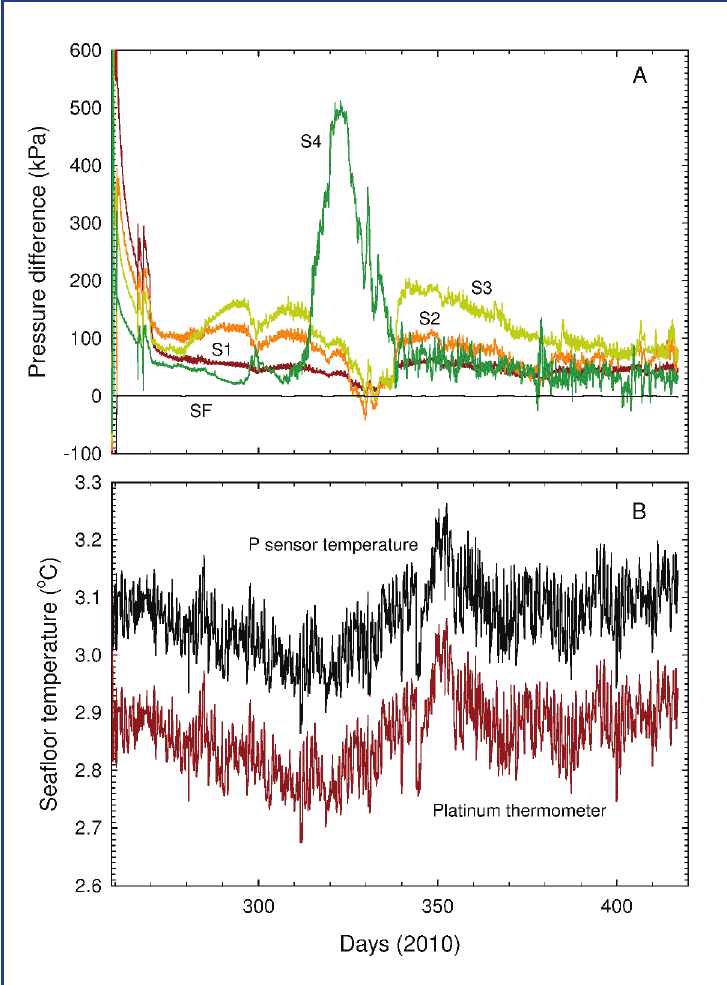
Figure 8. Full history of [A] seafloor (tides filtered) and relative formation pressures and [B] seafloor temperature observed prior to failure of the seafloor pressure sensor on 21 February 2011 (day 417). Scaling convention for pressures is the same as in Figs. 4–6. Temperatures (offset for plotting clarity; absolute values to be calibrated during the next ROPOS visit) are measured inside the main instrument pressure case with a platinum thermometer, and inside the seafloor pressure sensor with a quartz